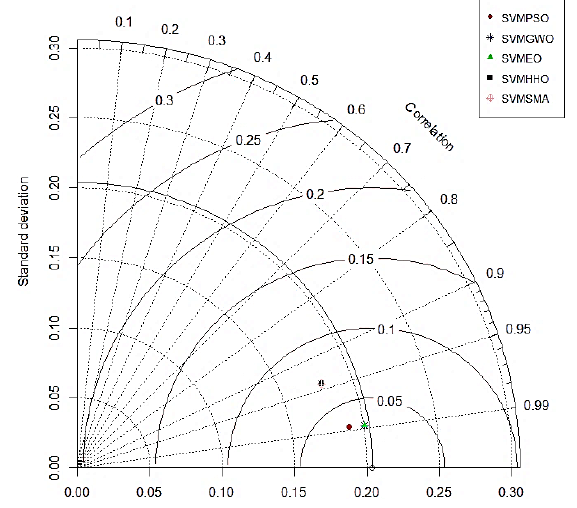
Figure 7. Taylor diagram for the training results.